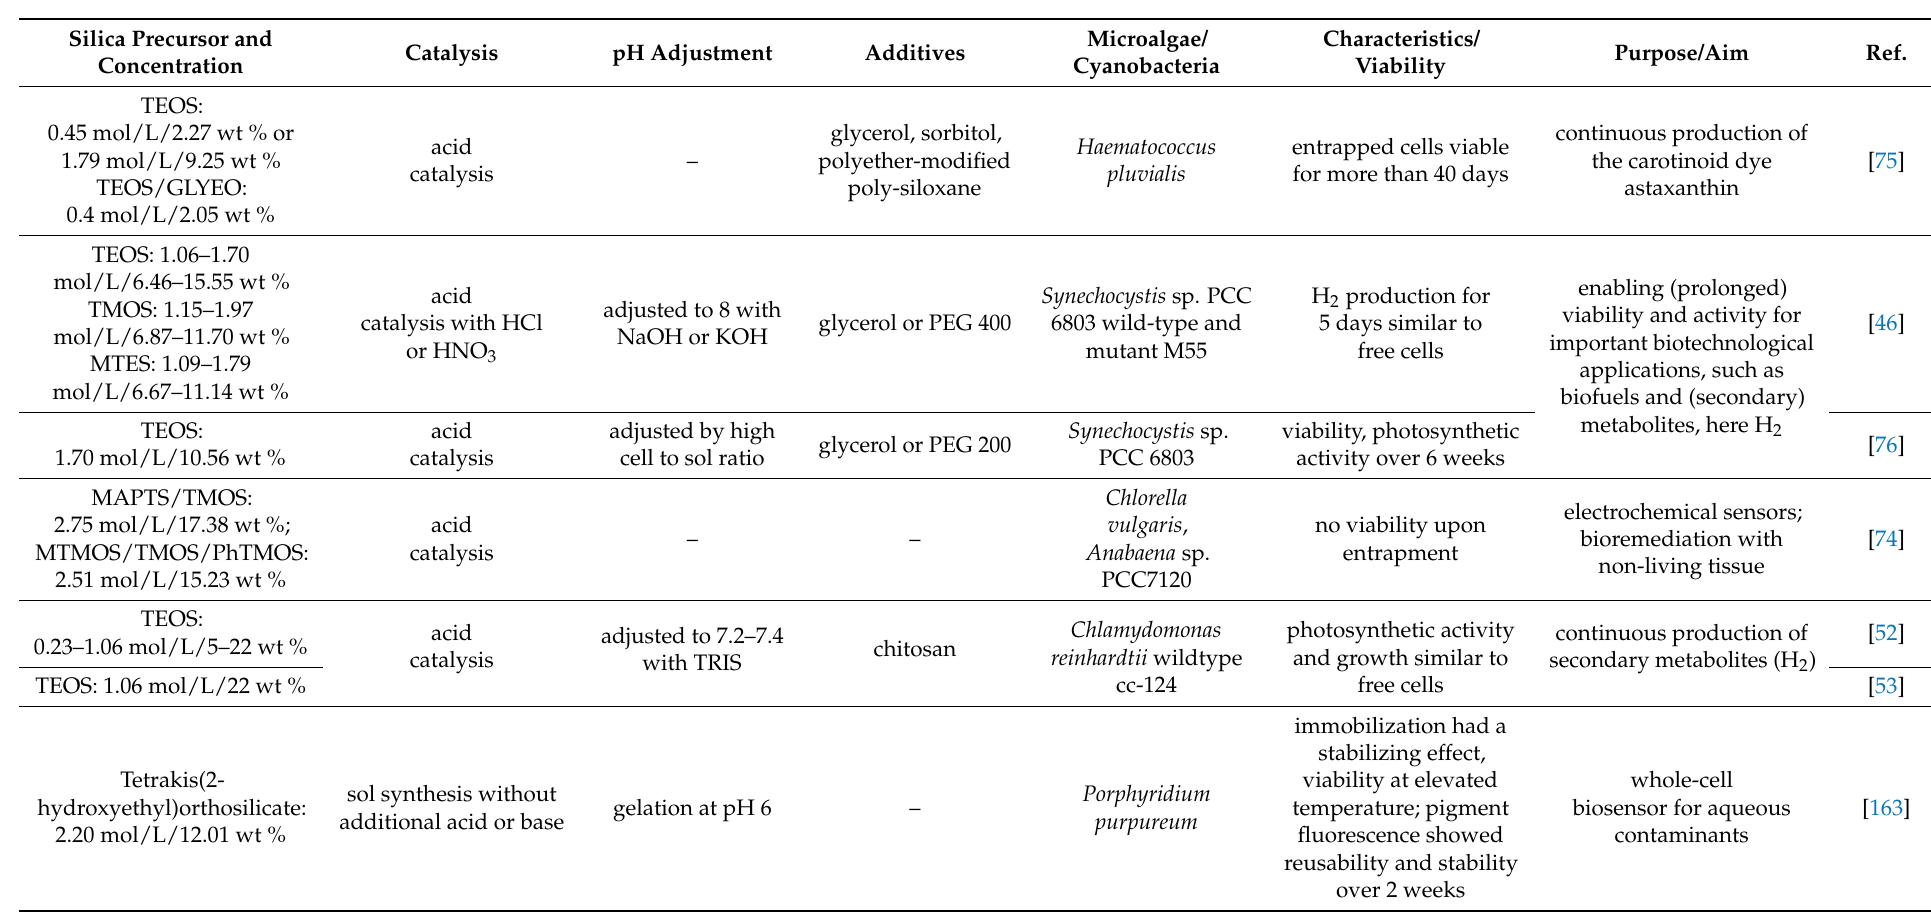
Table 1. Overview of microalgae entrapment in alkoxysilanes. TEOS: tetraethyl orthosilicate; GLYEO: (3-glycidyl-oxypropyl)triethoxysilane; MTES: methyltriethoxysi- lane; MAPTS: 3-(trimethoxysilyl)propyl methacrylate; TMOS: tetramethyl orthosilicate; MTMOS: methyltrimethoxysilane; PhTMOS: